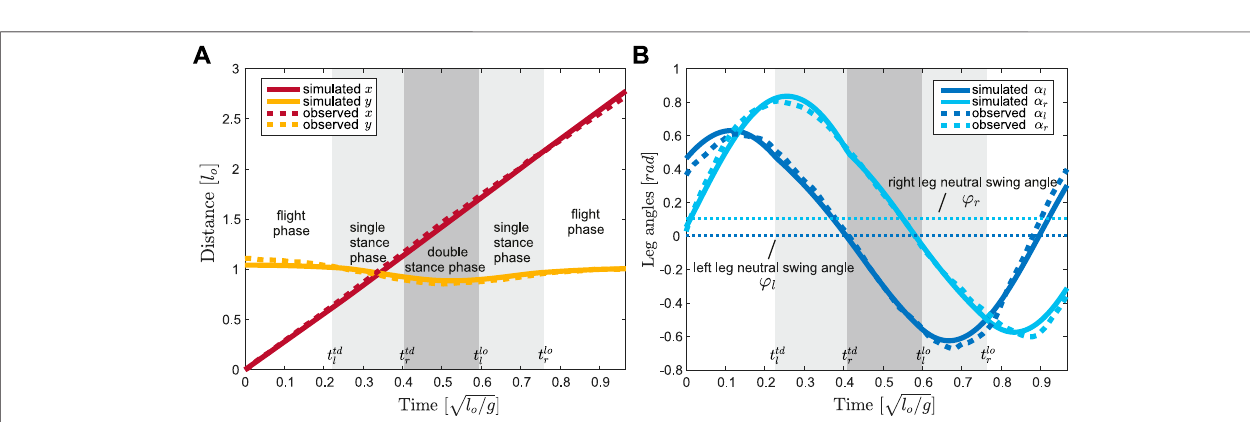
] oftrial1802 − j 30closelymatchtheempirical , α r 0 0